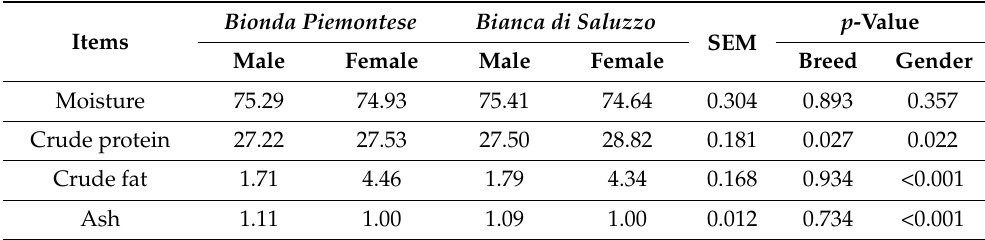
Table 5. Average chemical composition (g/100 g FM) of thigh meat of Bionda Piemontese and Bianca di Saluzzo breeds. Data are the average of the four-consecutive slaughtering at 5, 6, 7, and 8 months of age ( n = 32). Bionda Piemontese Bianca di Items